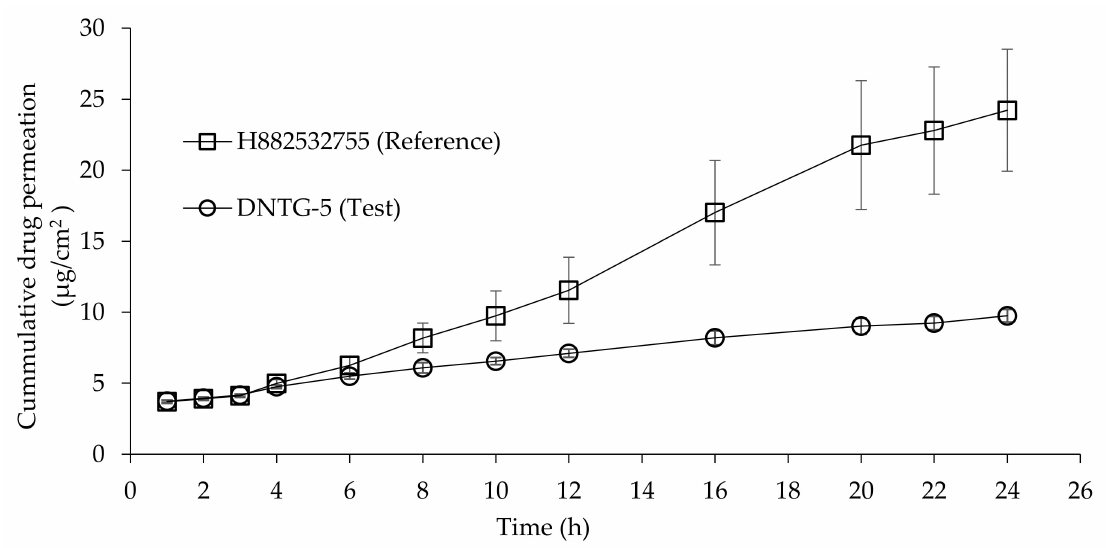
Figure 6. Desoximetasone permeation profile for H882532755 and DNTG-5 formulations. Time points were measured at 1, 2, 3, 4, 6, 8, 10, 12, 16, 20, 22, and 24 h. Each point represents the mean ±